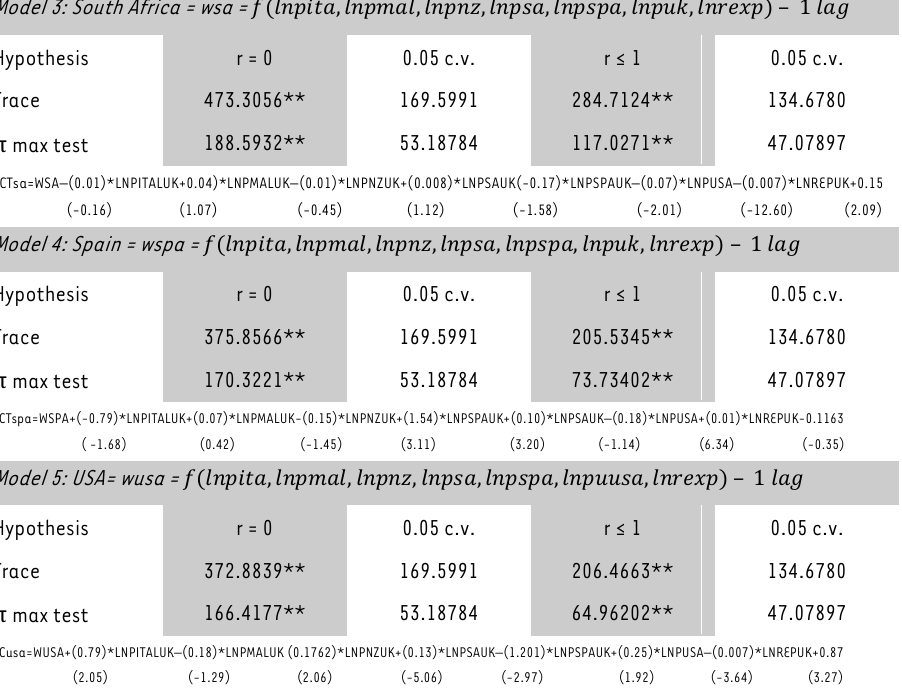
Model 5: USA= wusa